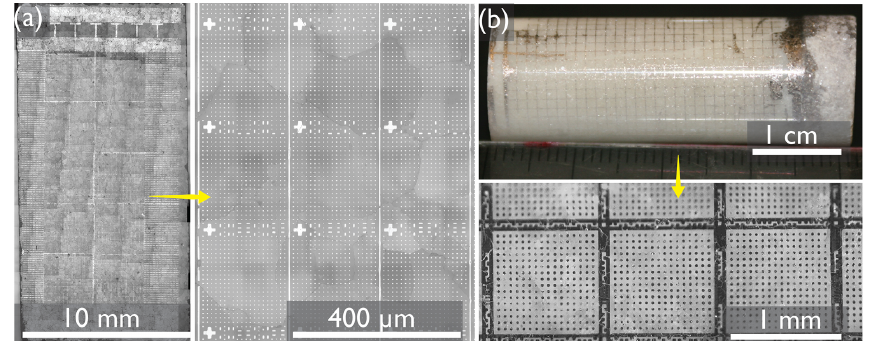
Figure 2. Patterned Carrara marble using photolithography. (a) The optical light micrograph on the left shows the patterned half cylinder with more than 1.5 million markers, while the micrograph on the right presents a zoomed-in view of an area revealing the 2µm wide markers with centers spaced every 10µm and the embedded numbering system that allows us to locate each marker before and after deformation. (b) The photograph on top illustrates the structure of a patterned cylinder, while the optical light micrograph on the bottom shows a closer view of the patterned curved surface revealing 20µm wide markers with centers spaced every